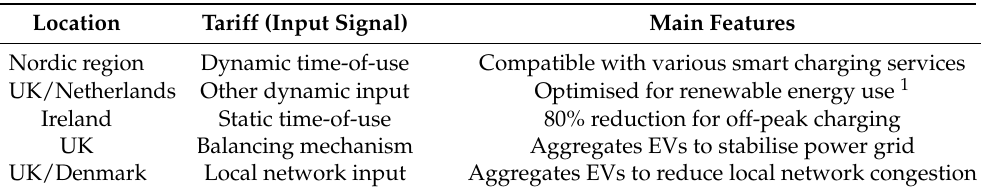
Table 1. Examples of smart EV charging tariffs and